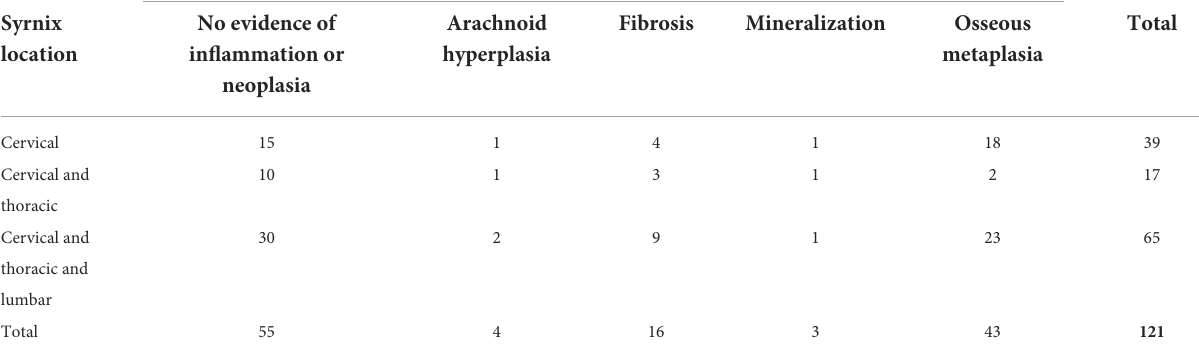
Histopathologic diagnosis